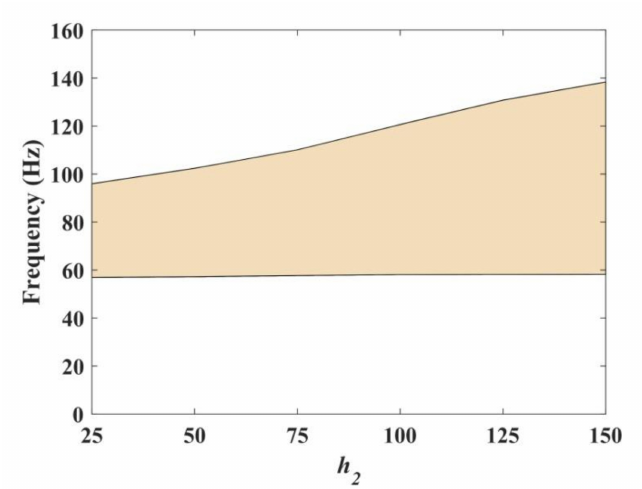
Figure 10. The influence of h 2 on the band gap.